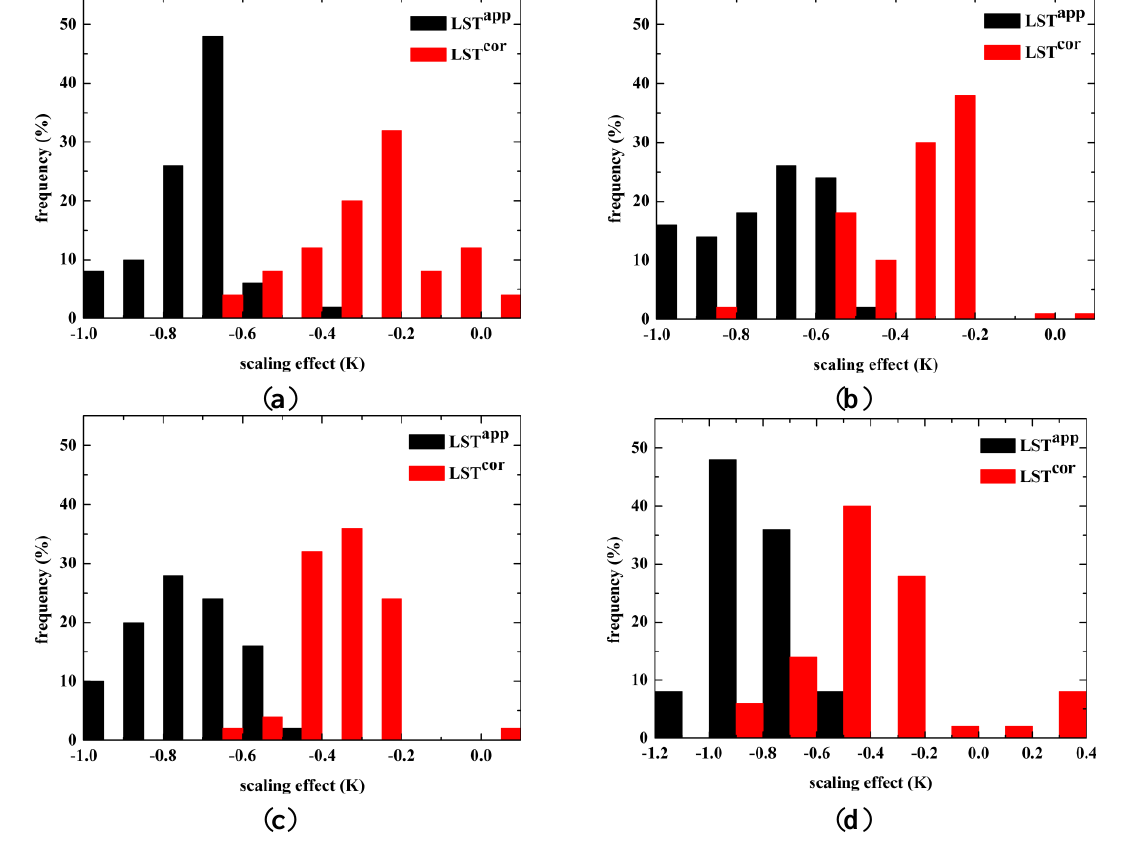
Figure 10. Histograms of the difference between the distributed LST and lumped LST before and after the scaling effect correction at ( a ) Site 1; ( b ) Site 3; ( c ) Site 4 and ( d ) Site 5 at a spatial scale of 300 m. The black bars ( 𝐿𝑆𝑇 𝑎𝑝𝑝 ) represent the frequencies of the scaling effect before the correction, and the red bars ( 𝐿𝑆𝑇 𝑐𝑜𝑟 ) represent the frequencies of the scaling effect after the